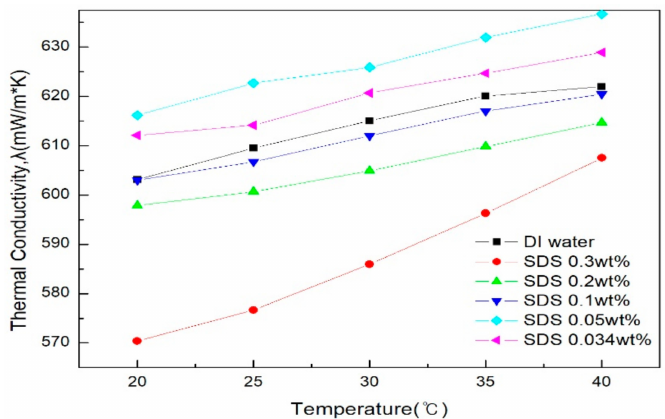
Figure 7. Thermal conductivity of graphene by SDS addition ratio.